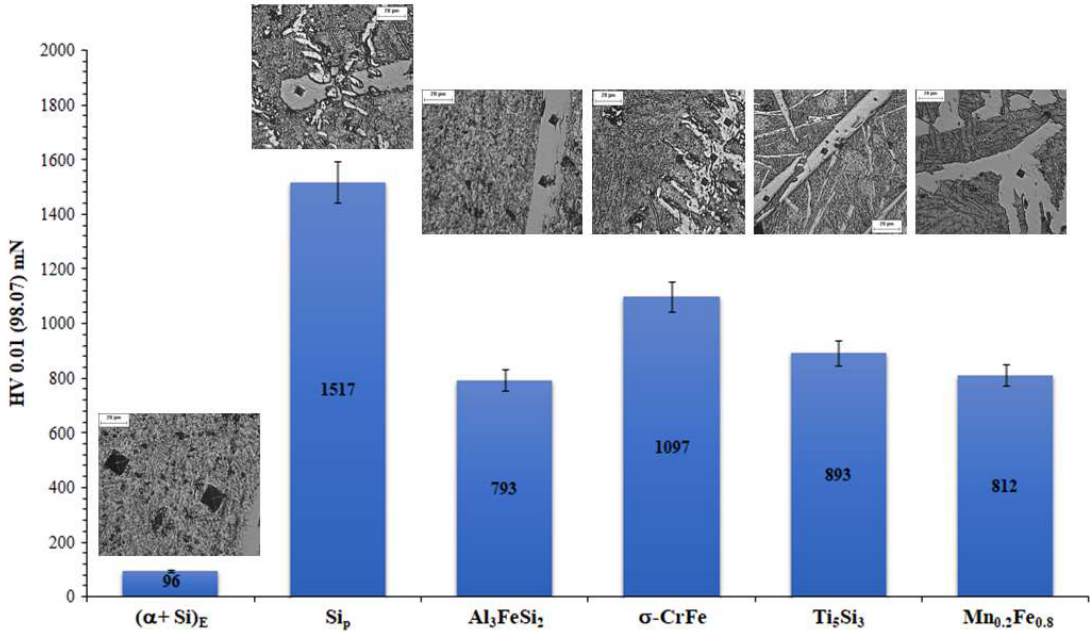
Figure 17. Microhardness of the different phases obtained.